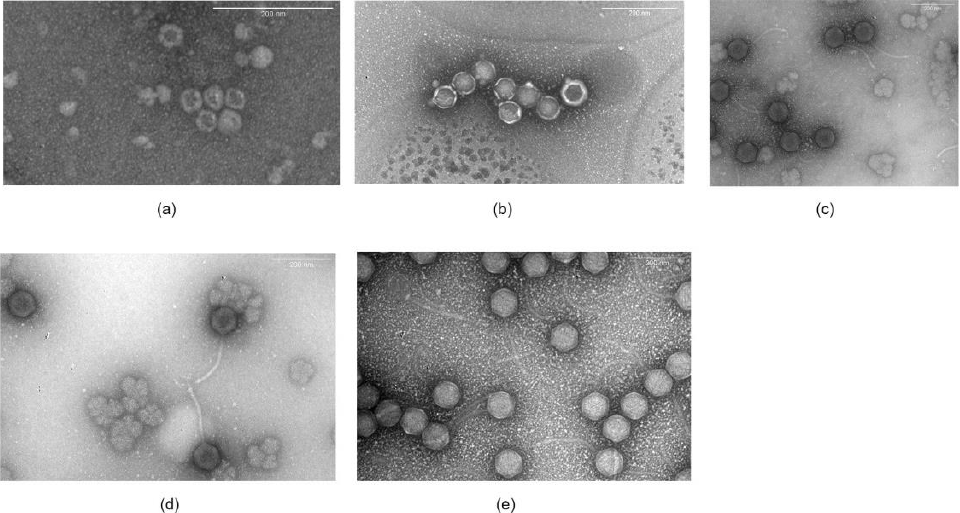
Figure 1. Electronic microscopy of transmission of phages ( a ) phage A.4 ( b ) phage A5, ( c ) phage, A7, ( d ) phage A8, and ( e ) phage B.3.